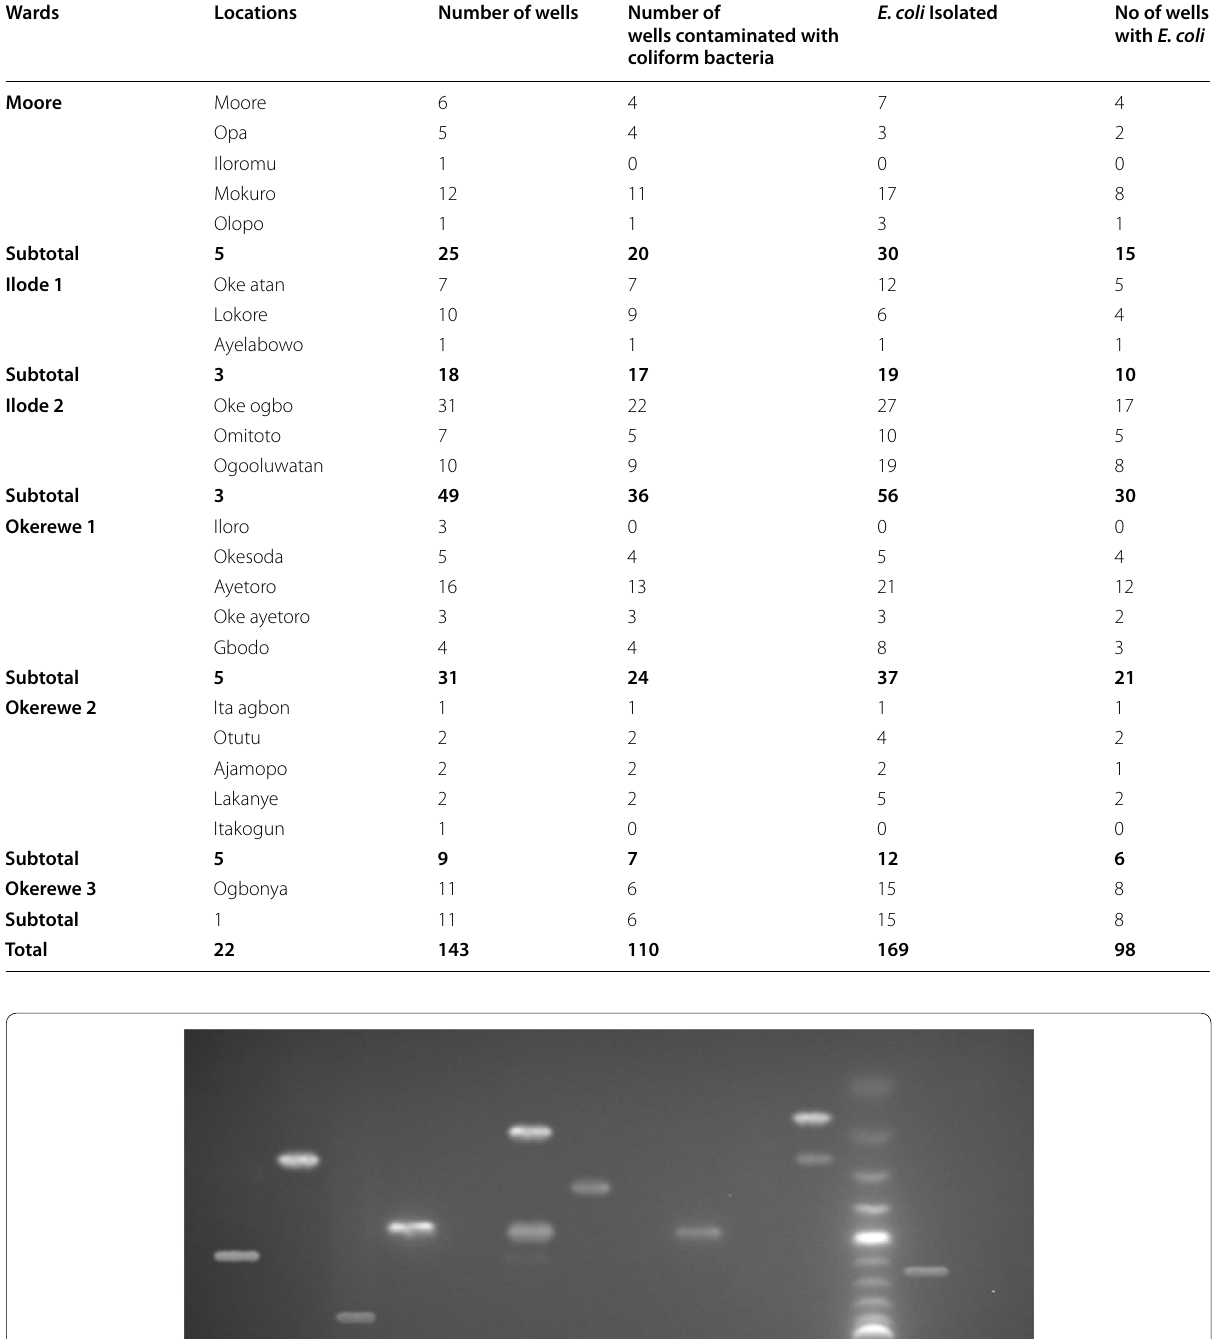
Table 3 Isolates distribution in the wards in the local government Wards